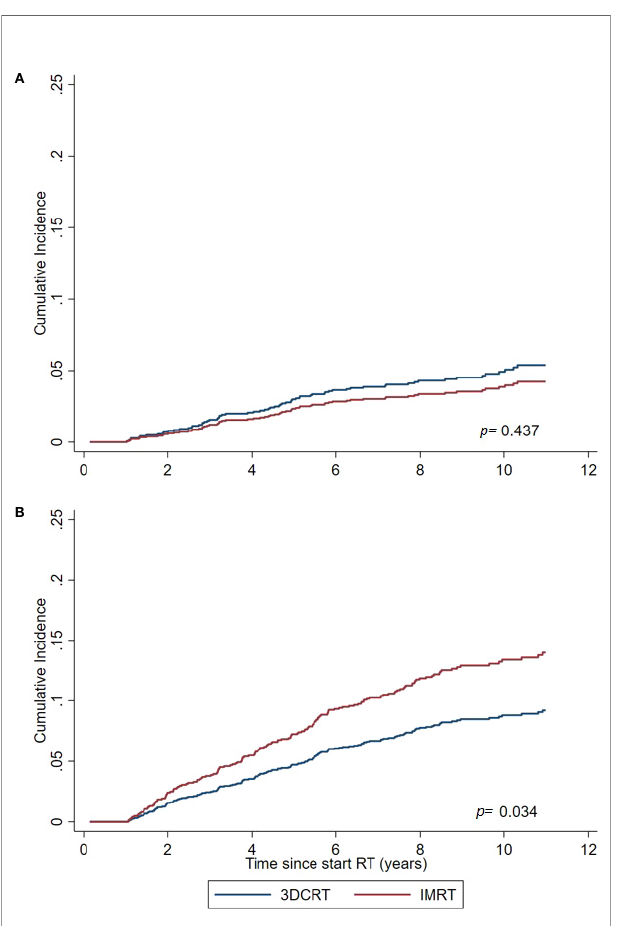
FIGURE 2 | Cumulative Incidence of non-pelvic SPCs for IMRT and 3DCRT subgroups, as estimated by the Fine and Gray model adjusted for calendar period and age. (A) PCa survivors aged 50 – 69 years at time of treatment. (B) PCa survivors aged 70 – 79 years at time of